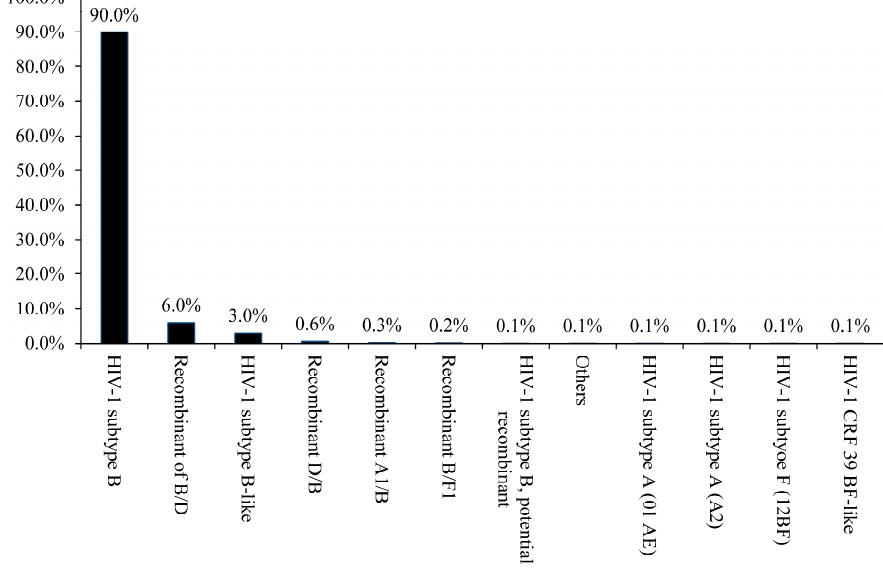
Figure 1. HIV-1 Subtype B is the predominant form in Puerto Rico (2001–2014). A total of 945 sequences were analyzed and the diagram was created by using Krona visualization tool [26].